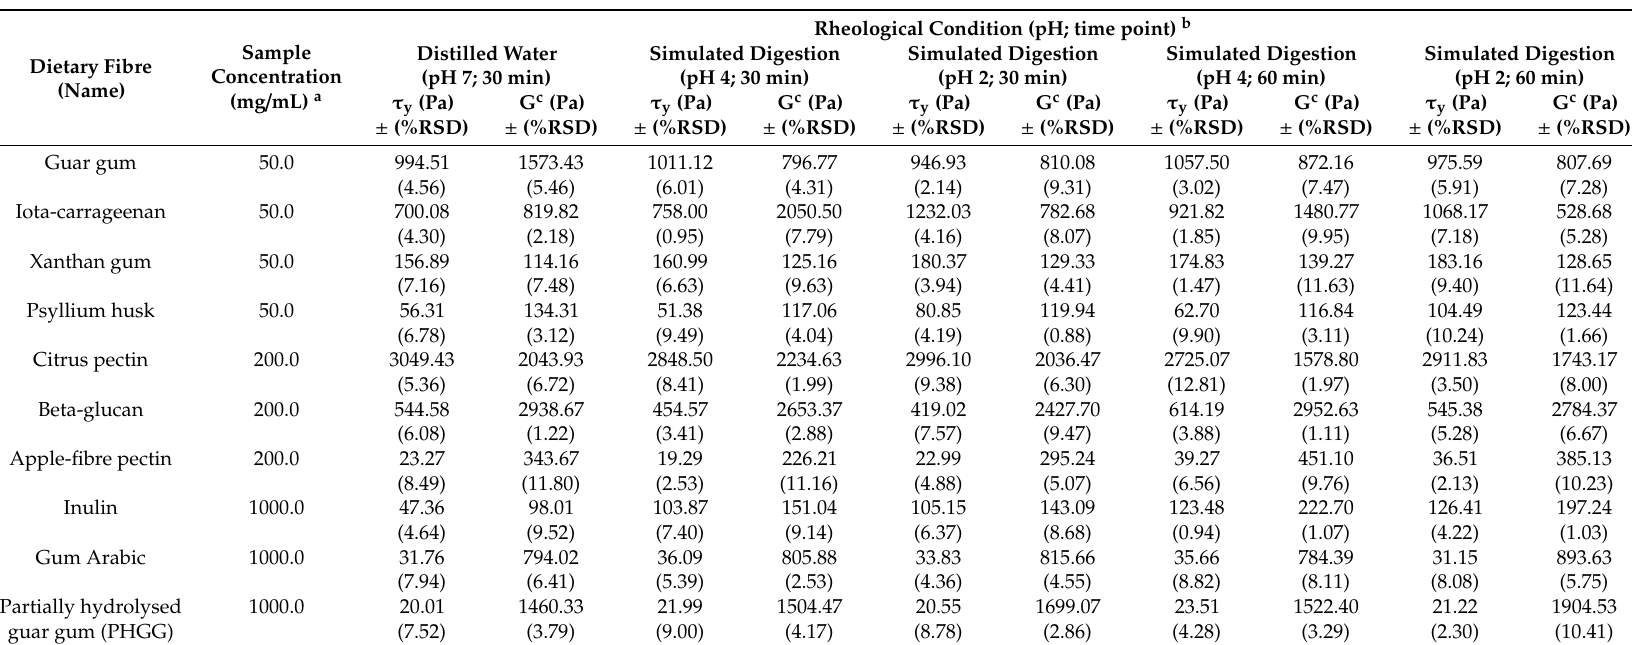
Table 3. Tabulated summary of yield-point shear stresses ( τ y ), crossover moduli (G c ) , and percentage relative standard deviation (%RSD) for the dietary fibre preparations in distilled water, and simulated digestion with gastric fluid at pH 4 and gastric fluid at pH